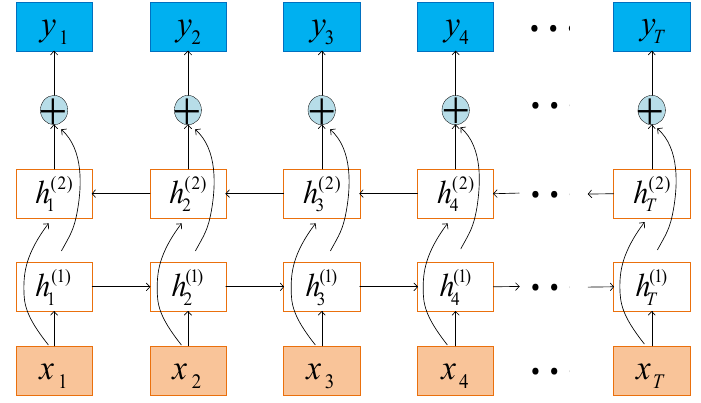
Figure 4. Two-way cyclic neural network expanded by time.